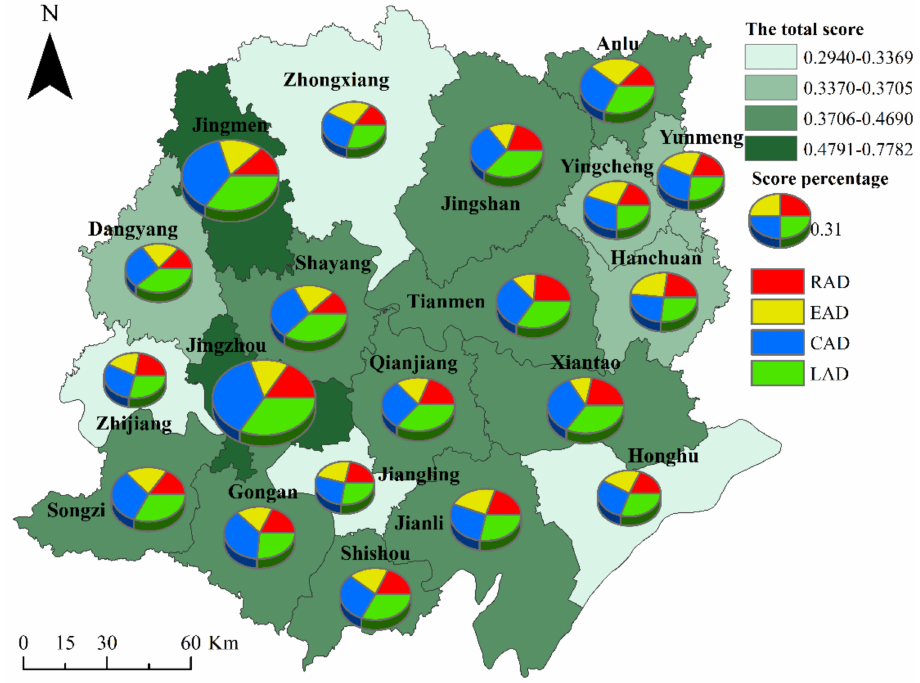
Figure 3. Spatial distribution pattern of livability level of rural living spaces in Jianghan